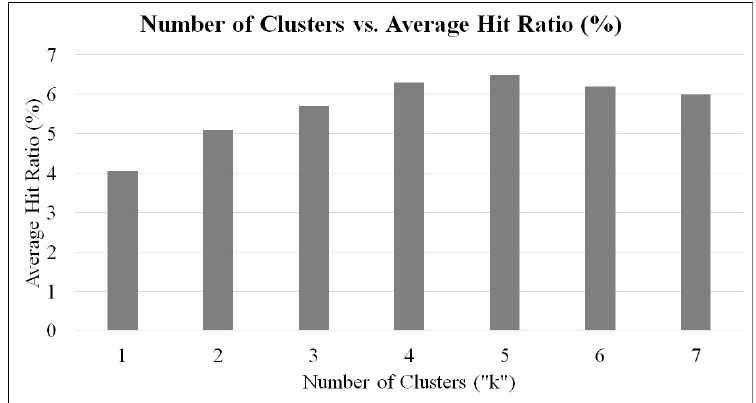
Figure 3. Average hit ratio on different number of clusters in Abilene network topology with | Ctlg | = 5000, | CS ( R ) | = 50, α = 0.7, λ = 0.7, | PT i